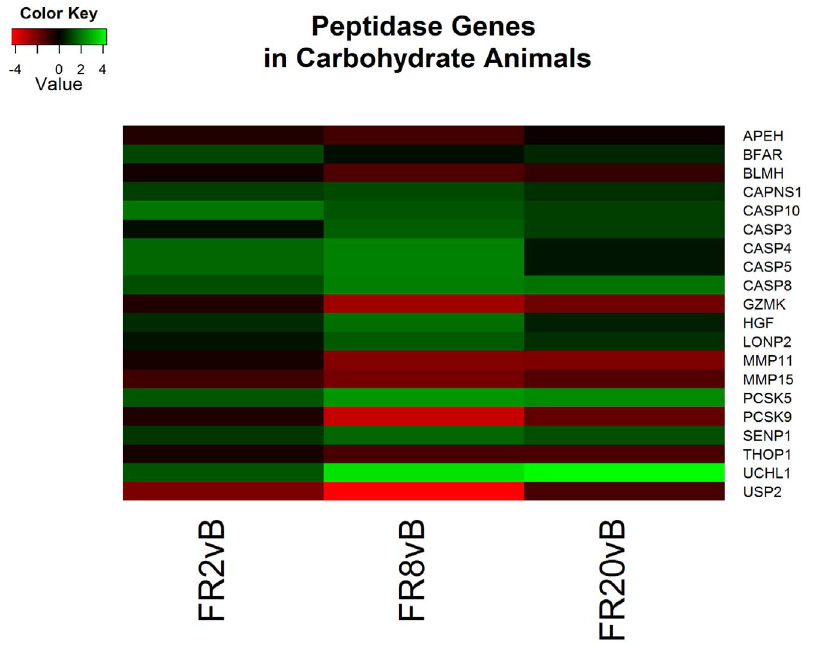
Figure 6. Heatmap of log2 fold changes of genes associated with peptidase activity in carbohydrate prefed (CPF) animals at each resuscitation timepoint (2, 8, and 20 hours) relative to Baseline (B). Rows are differentially expressed genes (DEGs) following RNA sequencing. Columns denote the respective timepoints Baseline (B), 2 hours full resuscitation change from Baseline (FR2vB), 8 hours full resuscitation change from Baseline (FR8vB), and 20 hours full resuscitation change from Baseline (FR20vB). Green denotes increased mRNA expression with respect to Baseline whereas red denotes the opposite.